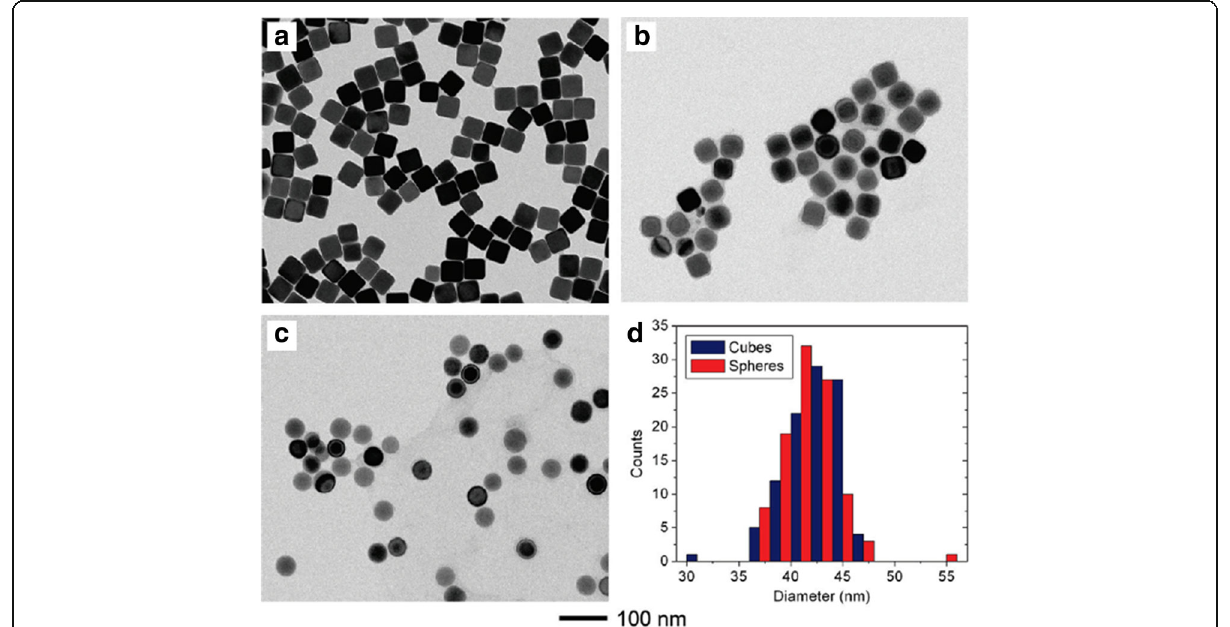
Fig. 4 TEM images ( a – c ) of 42 nm Ag cubes capped with PVP when etched with different volumes of 0.5 mM ferric nitrate. a 0 μ L. b 10 μ L. c 100 μ L. d Size distributions calculated from 100 particles in parts a and c